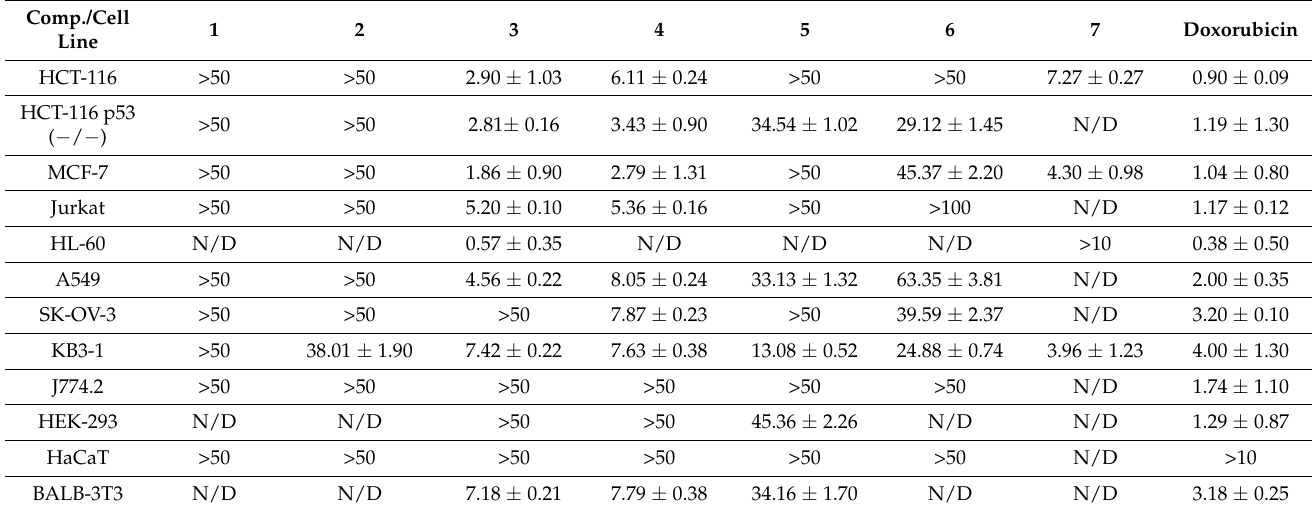
The time-dependent cell viability data were obtained as a result of 24, 48, 72, and 124 h MTT tests performed with the most active compound 4 on MCF-7 cell line. A strong correlation was detected between the treatment time and an anti-proliferative potential. The cytotoxic effect of this compound develops after 48 h of incubation. This feature may explain the difference of cell viability compared with the NCI results which were obtained at 48th hour of incubation of cells with derivative 4 . A new pyridine-thiazole derivative was found to kill only 19.9% of the growing cells at the 24th hour, while at the end of 124 h, 90% of the breast cancer cells died, as seen in Figure 9. The result obtained at 48th hour of treatment of the MCF-7 cells with the compound 4 in concentration 10 µ M correlates to some extent with data of the NCI screening. At that time point, 43% of the cells died.